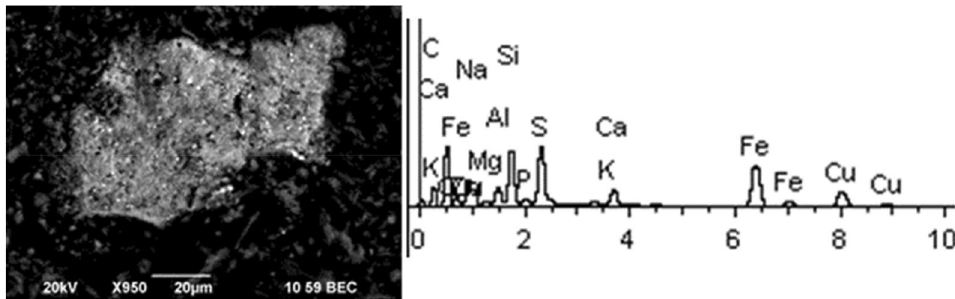
Figure 7. Aluminum degreasing. Particles morphology. Scanning electronic microscopy. Magnification ×950.